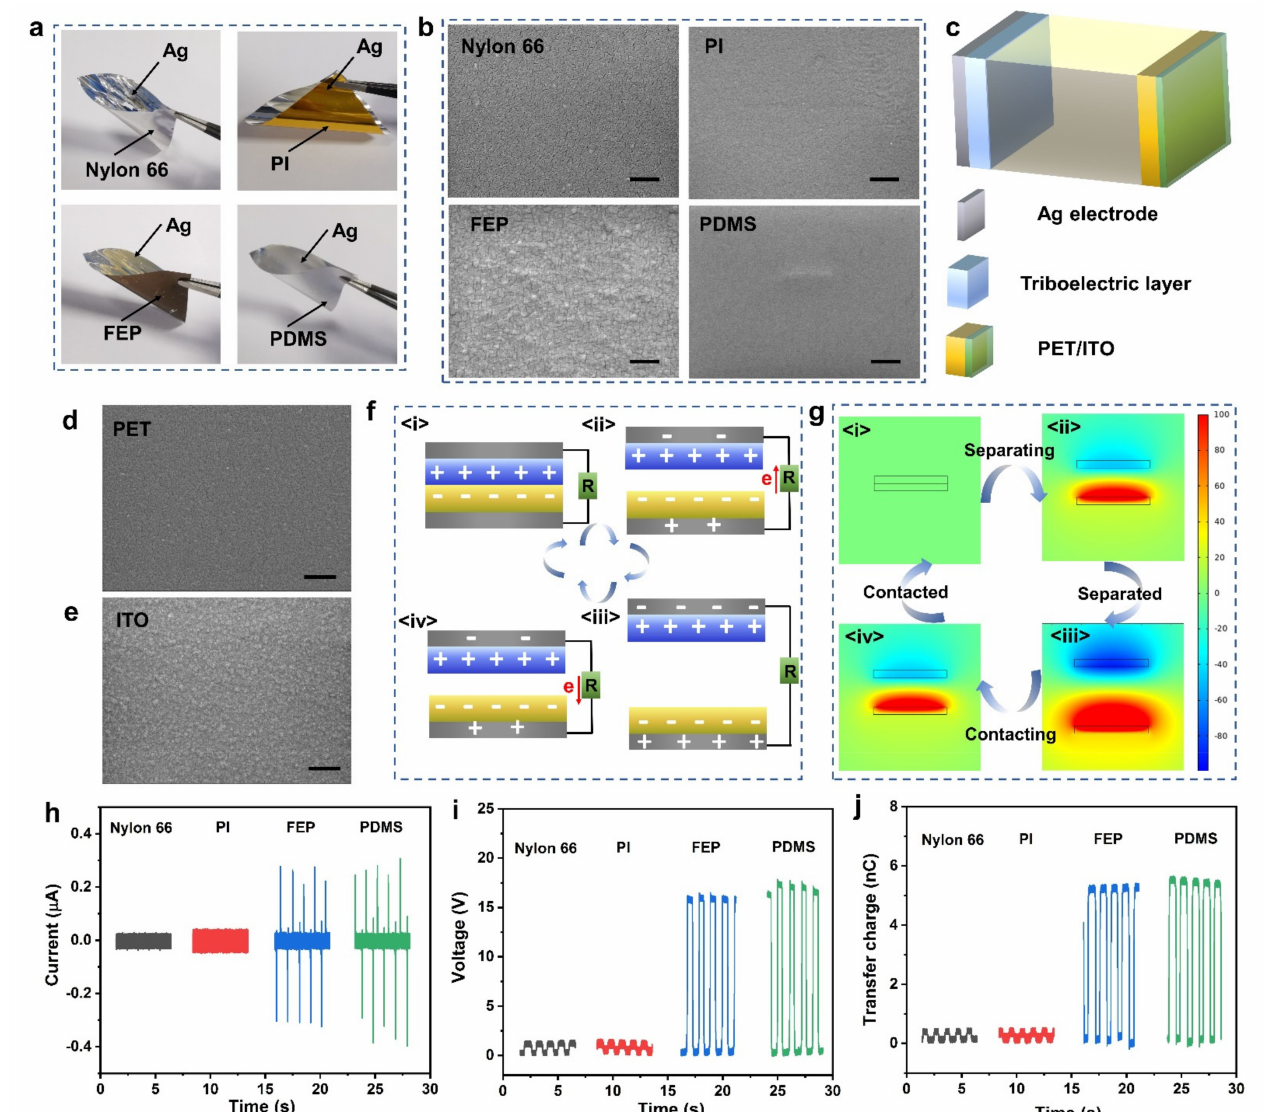
Figure 3. Triboelectric nanogenerator (TENG) output based on sputtered Ag induction electrode. ( a ) Optical images of different polymer films with the sputtered Ag; ( b ) SEM images of nylon 66, polyimide (PI), fluorinated ethylene propylene (FEP), and Polydimethylsiloxane (PDMS); ( c ) Schematic of the dual-electrode contact–separation TENG, the contact area of TENG is 4 cm 2 ; ( d , e ) SEM images of polyethylene glycol terephthalate (PET) and indium tin oxide (ITO); ( f ) Schematic diagram of the working principle of TENG; ( g ) Electrostatic simulation of TENG during a periodic contact–separation movement; ( h – j ) The electrical signals of TENGs based on different triboelectric systems. The scale bars represent 500